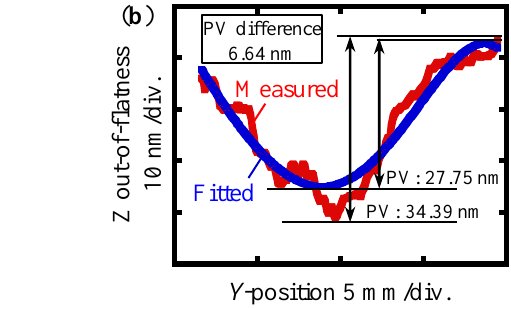
Figure 6. Central cross-sections of the Z -directional out-of-flatness shown in Figure 5. ( a ) Central cross-section along the X -direction; ( b ) Central cross-section along the Y -direction.